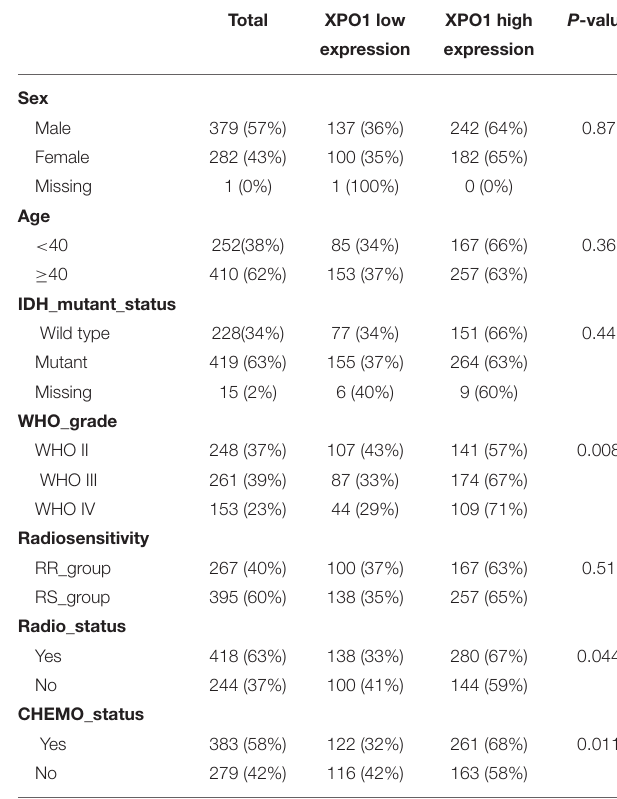
TABLE 1 | Demographics and clinicopathologic characteristics for glioma patients in the CGGA cohort.